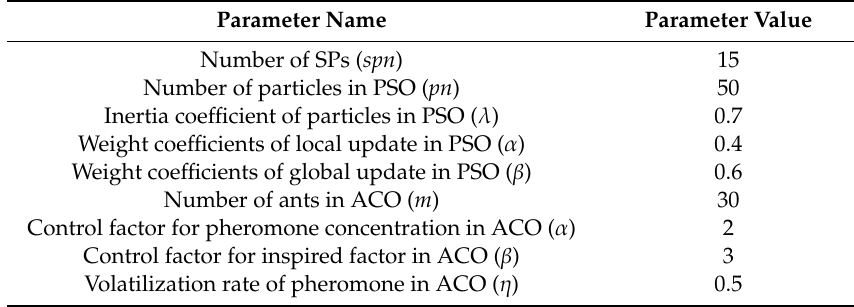
Table 2. Parameters for PSO and ACO.